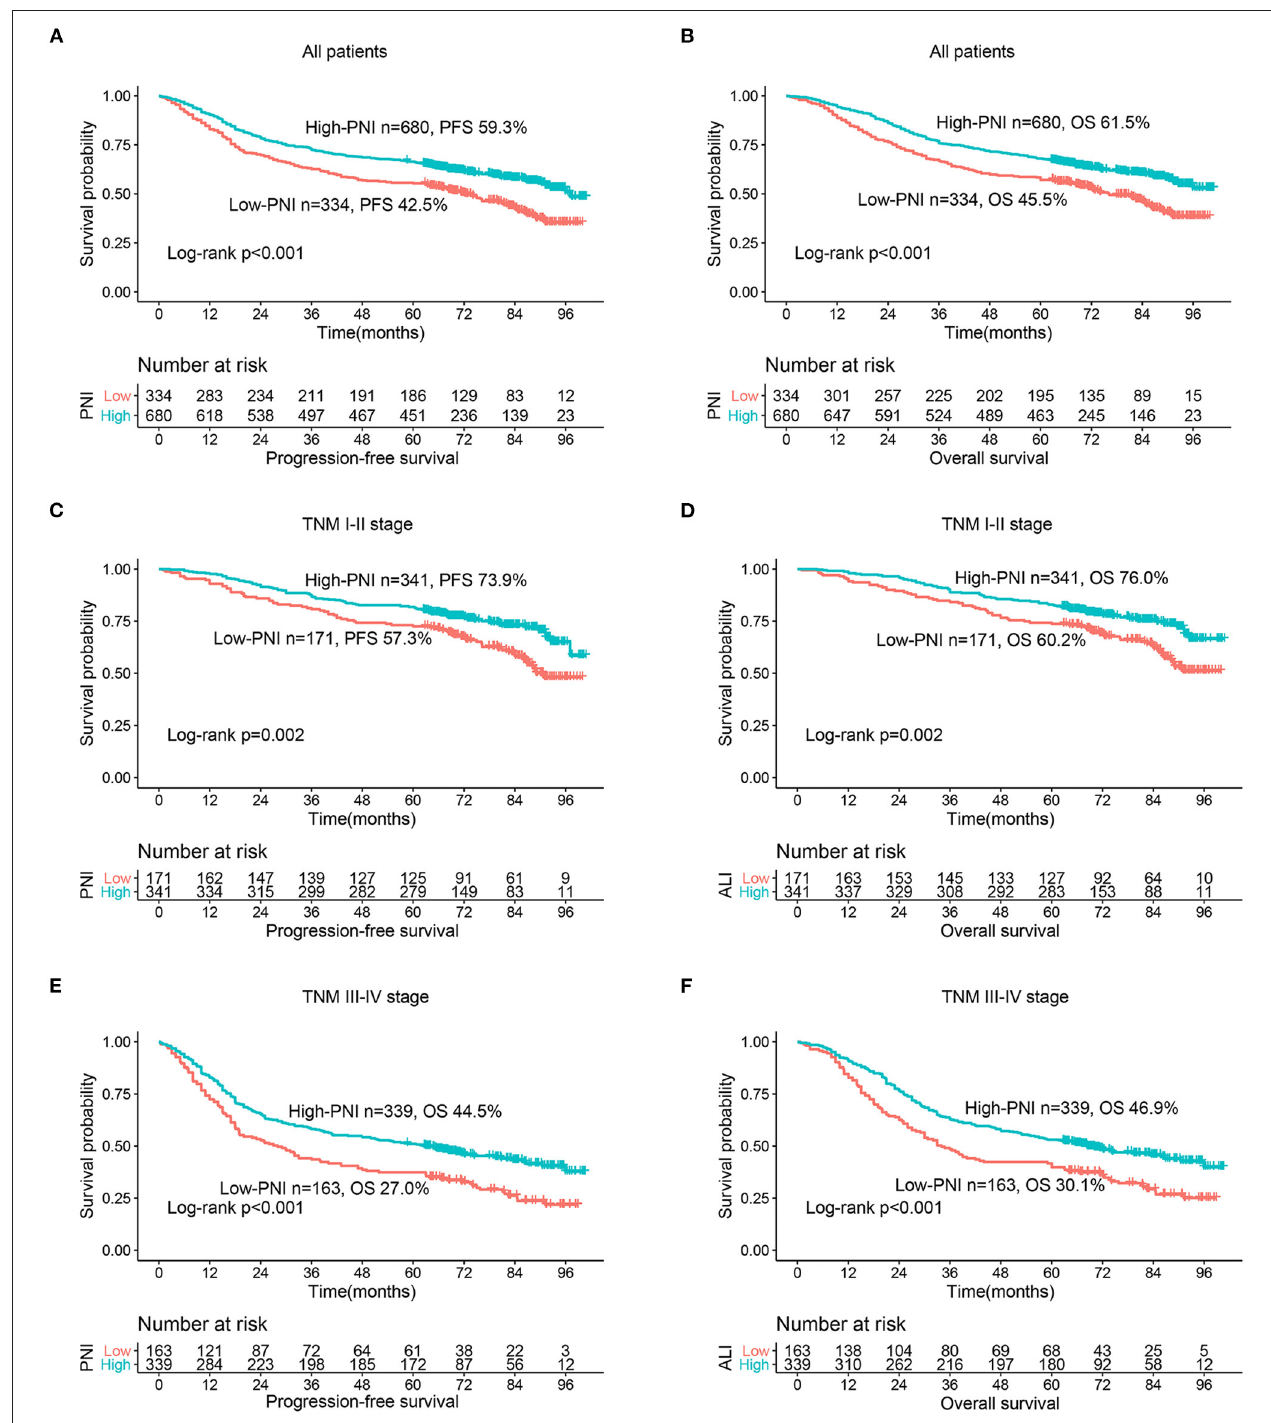
FIGURE 2 | Kaplan-Meier curves of different PNI groups in CRC patients. (A) PFS of PNI; (B) OS of PNI; (C) PFS of PNI based on TNM I-II stage; (D) OS of PNI based on TNM I-II stage; (E) PFS of PNI based on TNM III-IV stage; (F) OS of PNI based on TNM III-IV stage.